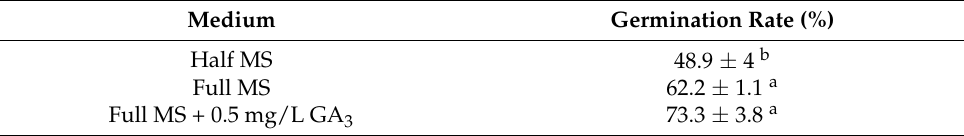
Table 1. In vitro seed germination frequency of Digitalis purpurea after three weeks. Medium